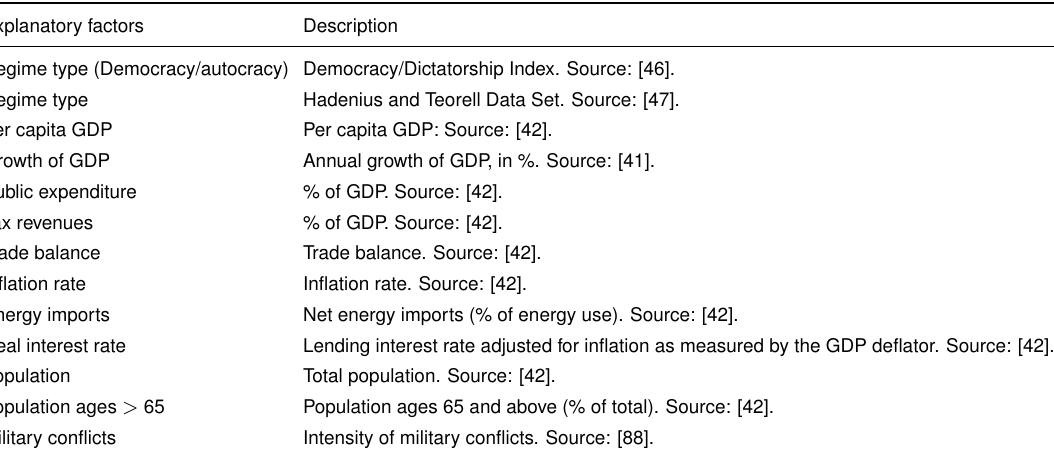
Table 2. Explanatory